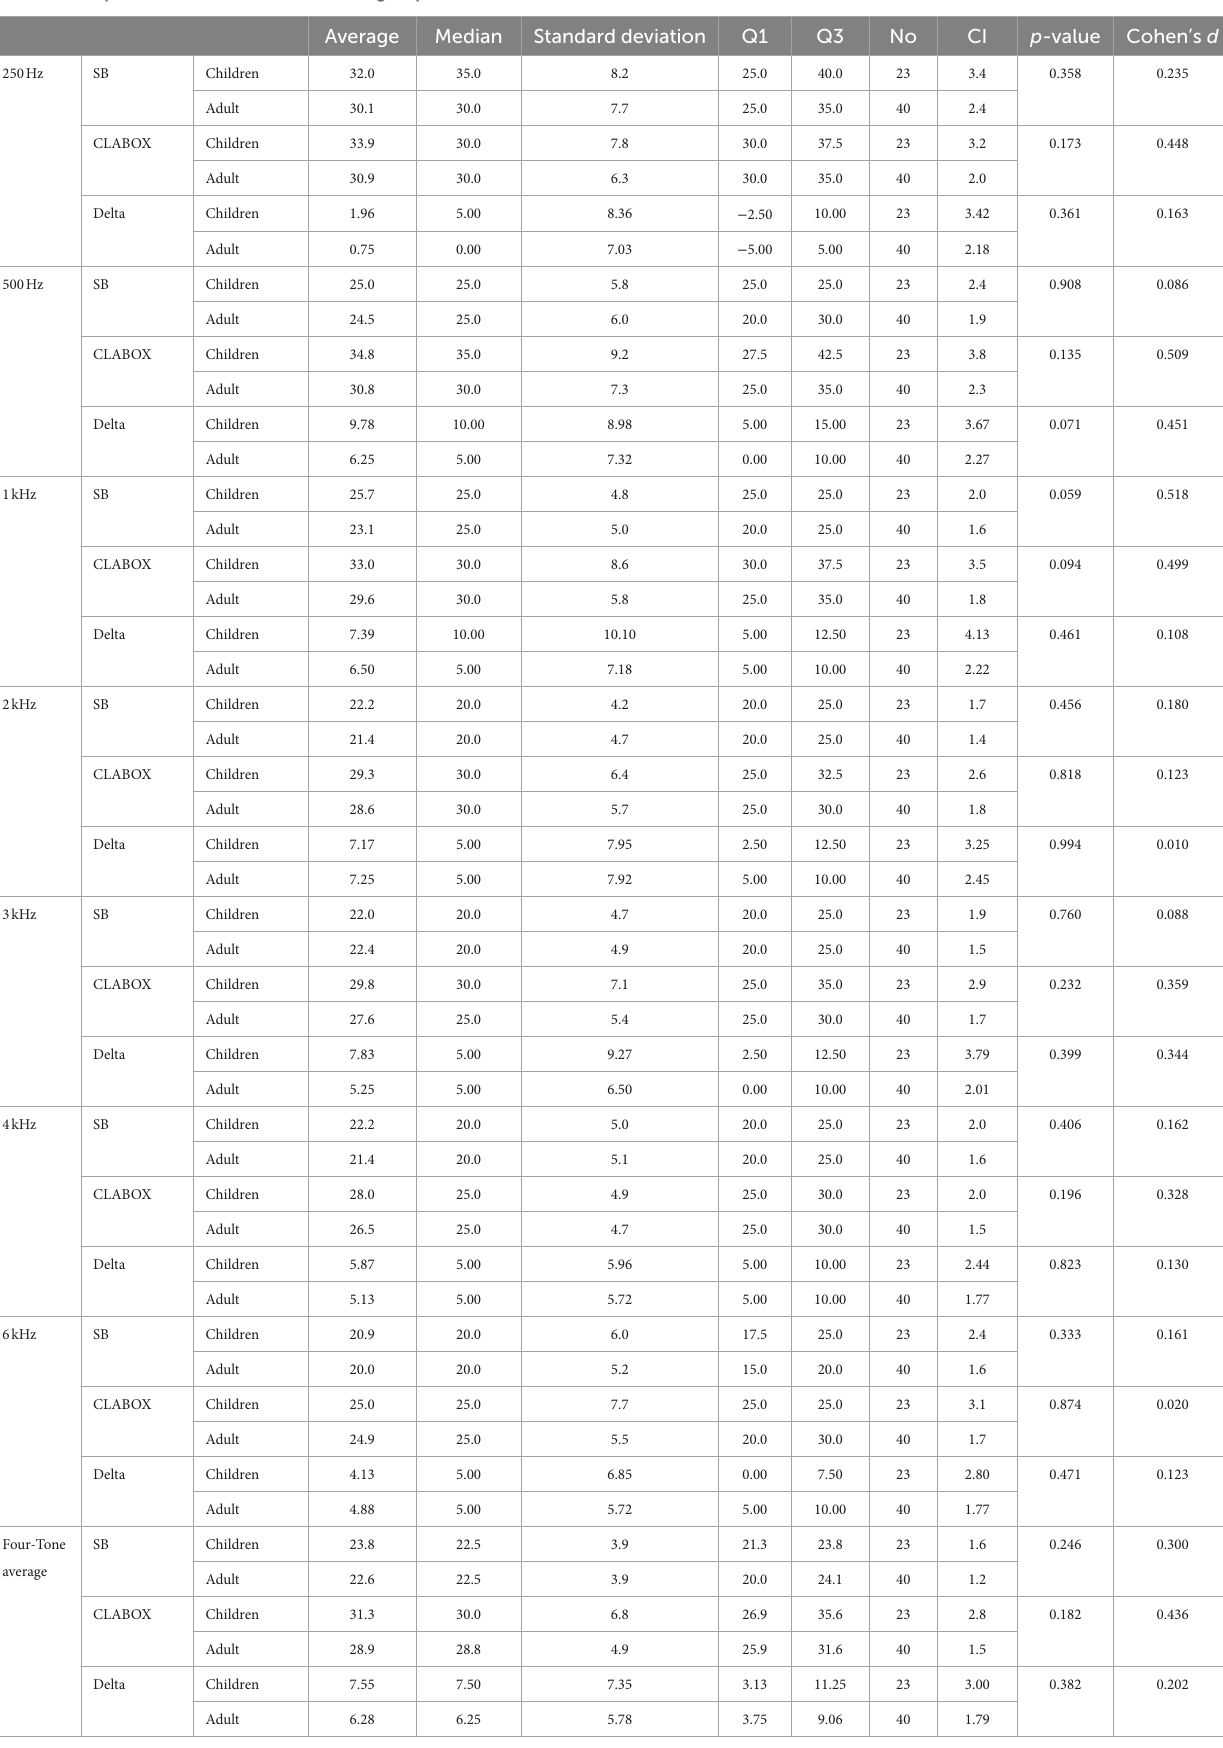
TABLE 2 Comparison of SB and CLABOX in the groups of children and adults in the PTA. Average Median Standard deviation Q1 Q3 No CI p -value Cohen’s